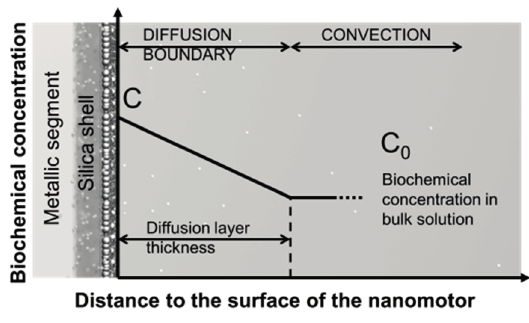
Figure 19. Schematic diagram of double layers next to the surface of the nanomotors. (small spheres: chemical molecules; big spheres: Ag NPs), with permission from